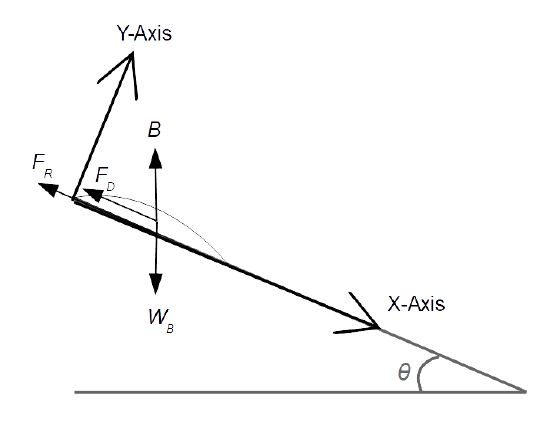
Figure A1. Free body diagram for landslide